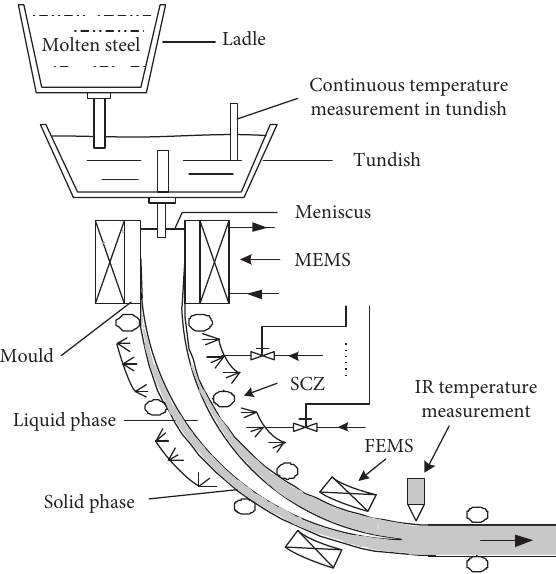
Figure 1: Diagram of billet continuous casting